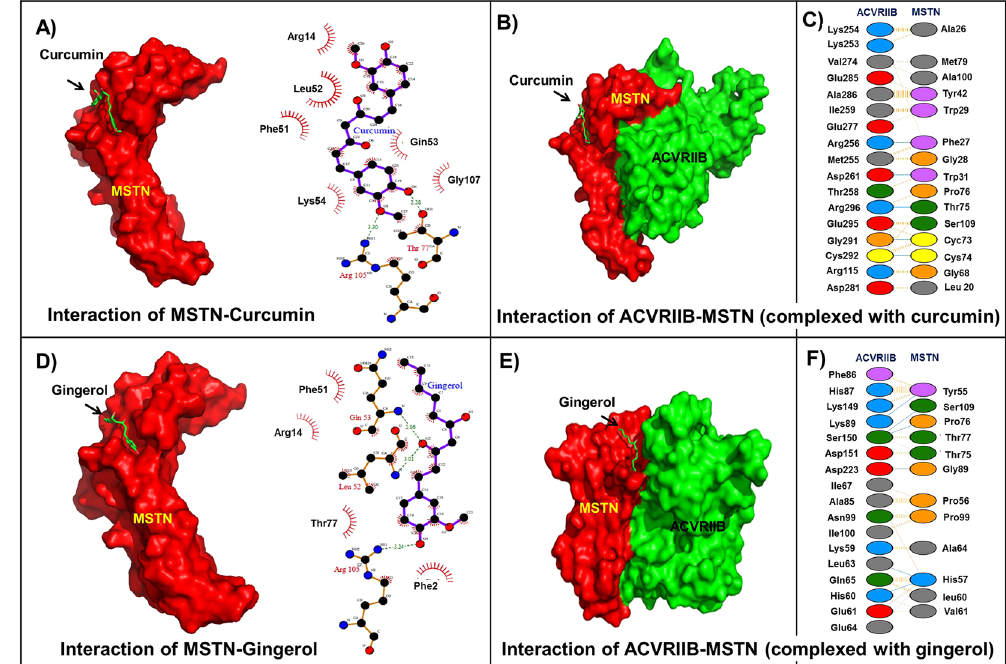
Figure 5. Interactions between curcumin or gingerol with myostatin and their effects on ACVRIIB. ( A ) Residual interaction between curcumin and MSTN in MSTN-curcumin complex ( B ) Interaction between ACVRIIB and MSTN-curcumin complex ( C ) Residual interaction between ACVRIIB and MSTN-curcumin complex ( D ) Residual interaction between gingerol and MSTN in MSTN-gingerol complex ( E ) Interaction between ACVRIIB and MSTN-gingerol complex ( F ) Residual interaction between ACVRIIB and MSTN- gingerol complex.